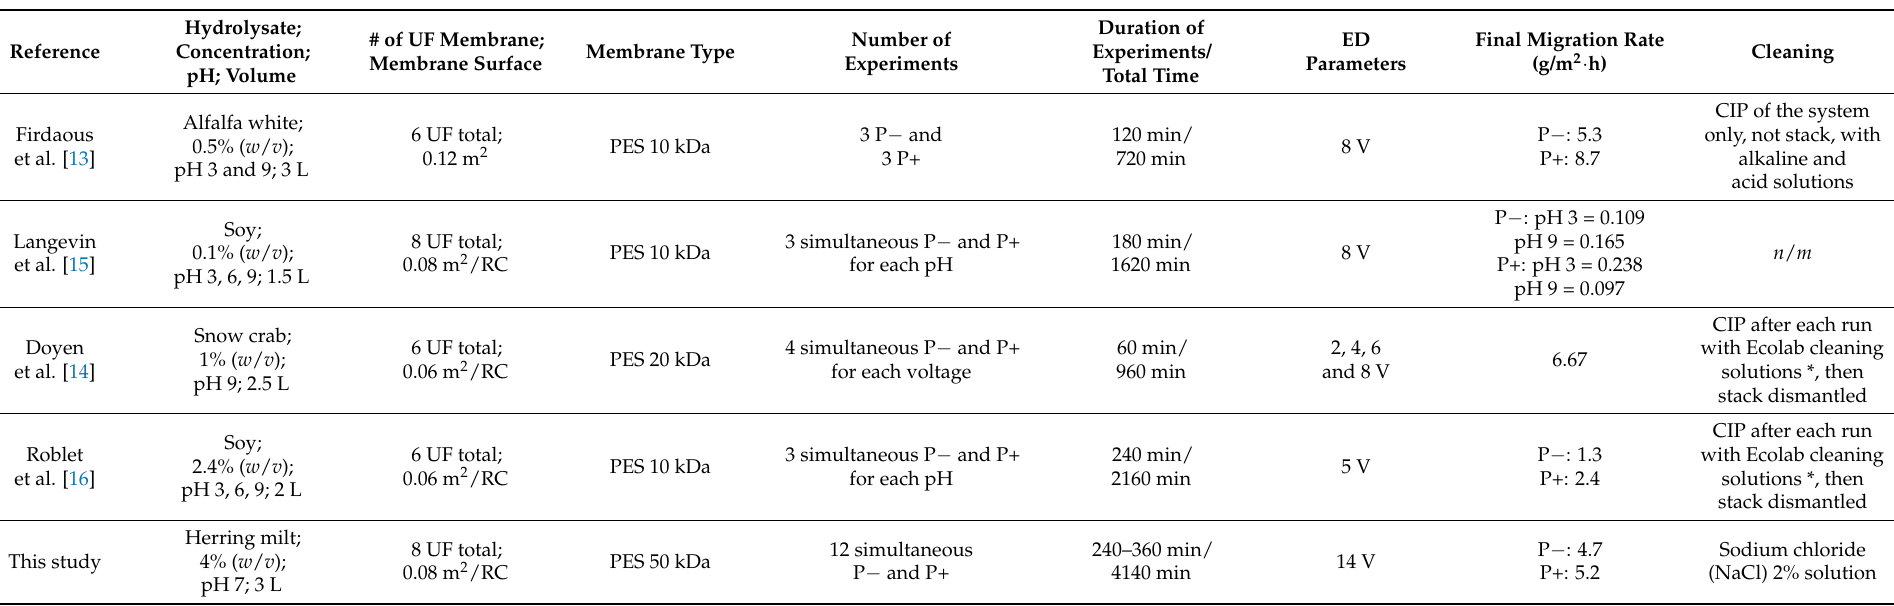
Table 1. Comparison of previous pilot-scale (EUR2-C stack) studies for the EDUF separation of different